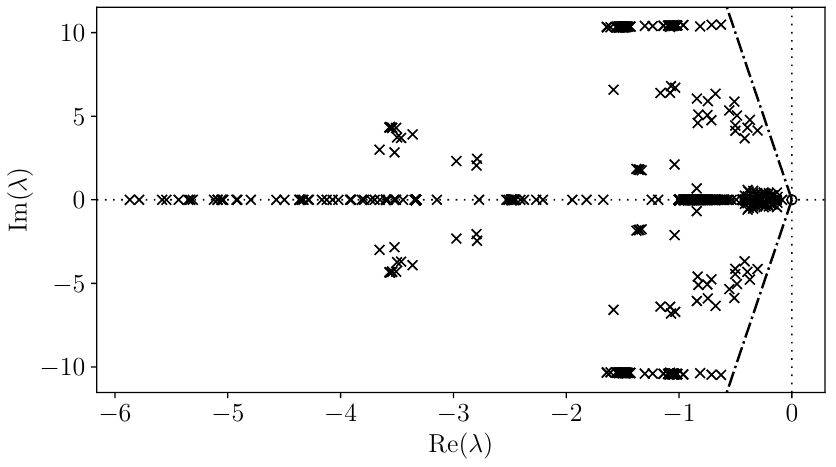
Figure 1. AIITS: root loci computed with